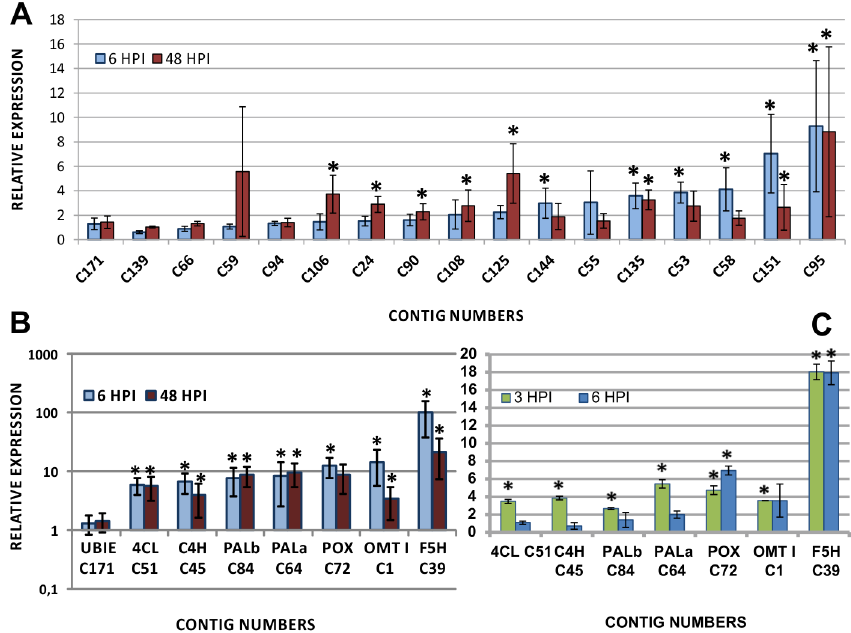
Figure 3. Verification of gene-activation by real-time RT-PCR. A) signal transduction-related genes. B) phenylpropanoid pathway and lignification genes. Ratios of mRNA levels compared to water-treated controls in the order of the strength of activation at 6 hours after treatment. Tobacco leaves were infiltrated with P. syringae pv. syringae hrcC- suspension, samples were taken 6 and 48 hours later. Values are averages of three independent biological replicates. Each replicate was normalized by corresponding actin levels. Stars indicate significant gene activation (p , 0.05) as compared to water treated controls. Contig C171 (ubiquitin extension protein) was used as a constitutive control. C) Flagellin as an elicitor of the phenylpropanoid pathway and lignification genes. Ratios of mRNA levels compared to water-treated controls are indicated. Tobacco leaves were infiltrated with flagellin22 peptide solution, samples were taken3 and6 hours later.Values areaverages of three independentbiological replicates. Each replicate was normalized by corresponding actin levels. Stars indicate significant gene activation (p , 0.05) as compared to water treated controls. Legend A) C139: sphingosine-1-phosphate lyase (SPL); C66: SR1 Nt-rab7b membrane-associated GTP-binding protein; C59: CND41, chloroplast nucleoid DNA binding protein; C94: phosphatidylinositol synthase; C106: putative PTS HPR protein involved in serine-phosphorilation; C24: NtMKP1 MAP kinase; C90: receptor-like protein kinase; C108: ethylene forming enzyme (EFE); C125: annexin-like protein; C144: WD repeat protein AN11; C55: 14-3-3 protein isoform; C135: DNA binding protein Rav; C53: calcium-dependent protein kinase 4 CDPK4; C58: MAP3K-like protein kinase; C151: NtHSF1 heat shock transcription factor; C95: Avr9/Cf-9 rapidly elicited protein 31 (ACRE31). Legends B) and C) PAL, Phenylalanine ammonia-lyase; C4H, cinnamate 4-hydroxylase; 4CL, 4-hydroxycinnamoyl-CoA ligase; OMT I, O-methyltransferase; POX, peroxidase; F5H, ferulate